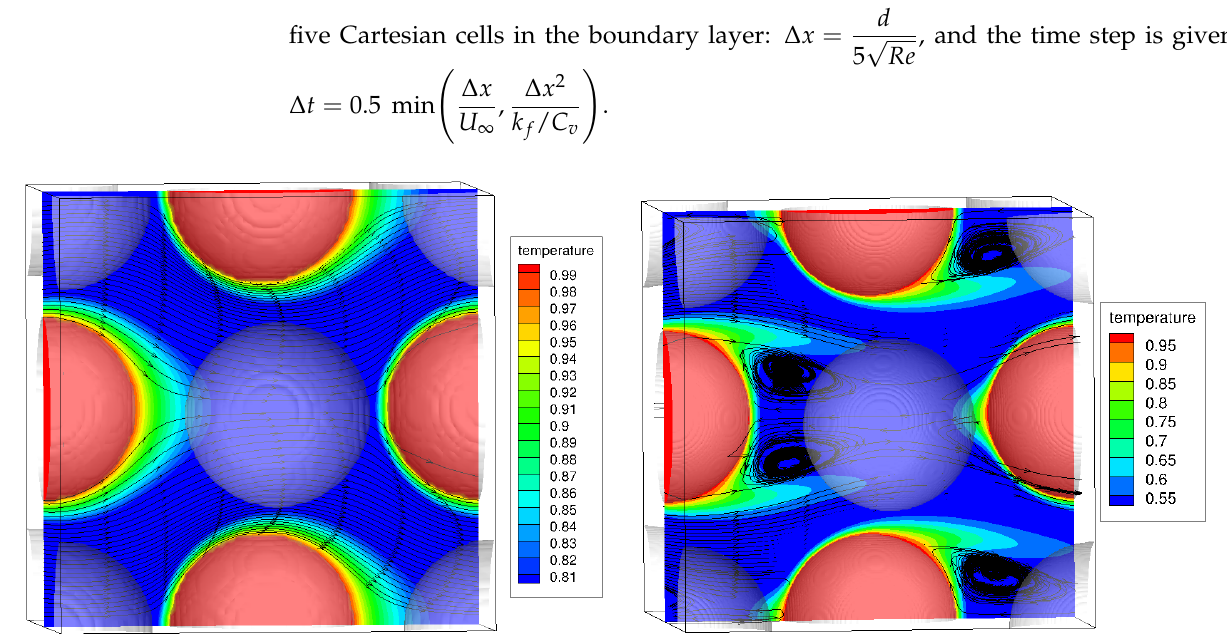
Figure 8. Streamlines and temperature field for a steady flow along the x-axis of a Face-Centered Cubic array of spheres at Re = 50, α d = 0.15 ( left ), and at Re = 300, α d = 0.15 ( right ). This case was previously used to validate the hydrodynamic force computation